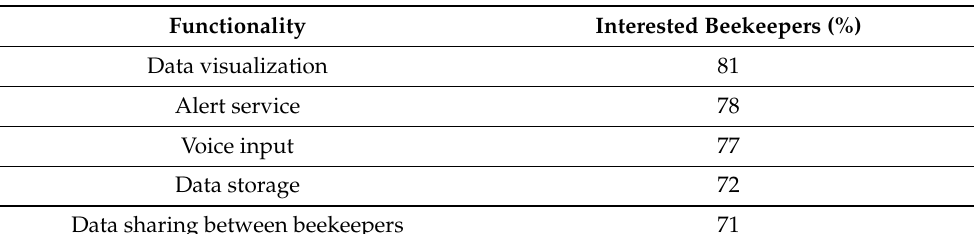
Table 3. Expectations of beekeepers regarding the functionalities to be integrated into a manage- ment platform.